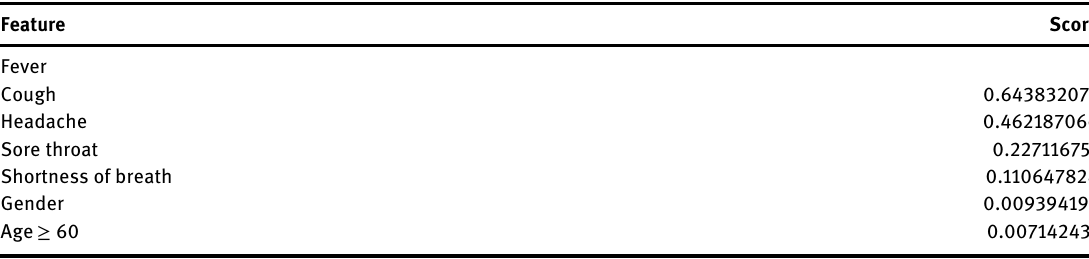
Table 3: The ranks/score of the significance of each clinical feature on the National Israeli COVID-19 DNA tests assigned by RF model on the first batch of the data (until Apr. 11,